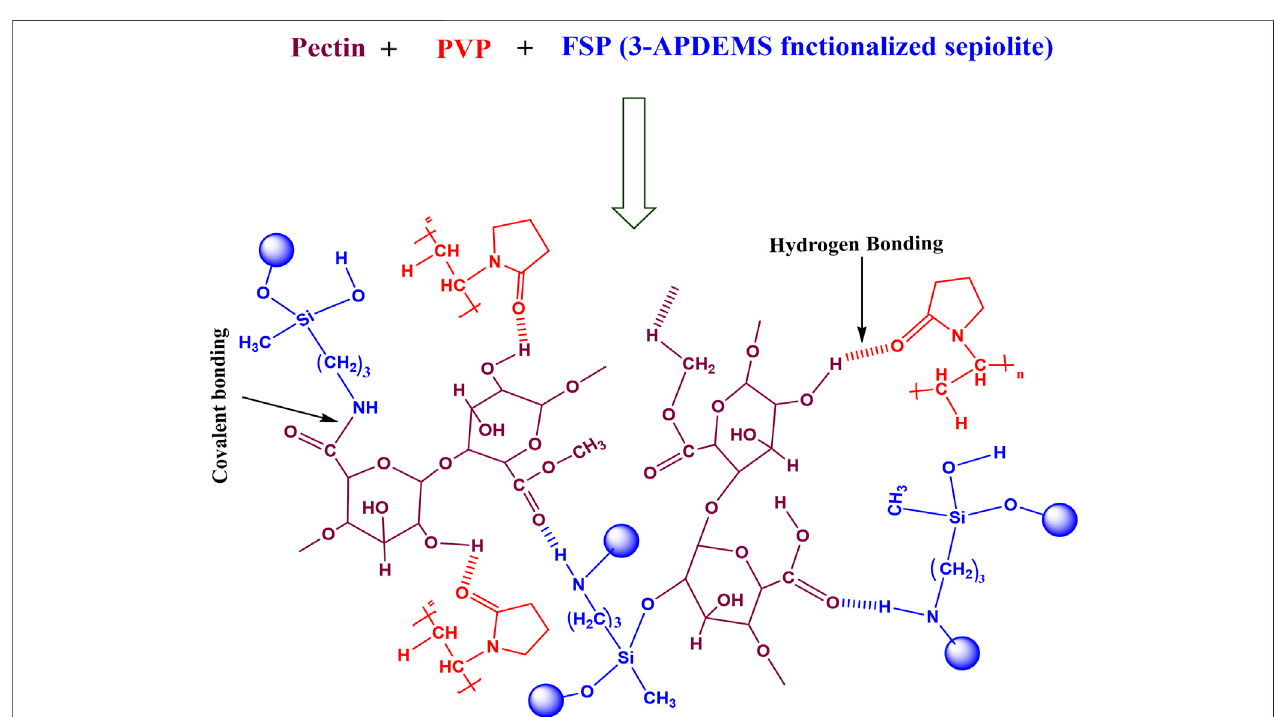
FIGURE 11 | Proposed crosslinked Pectin-PVP-FSP hydrogel matrix